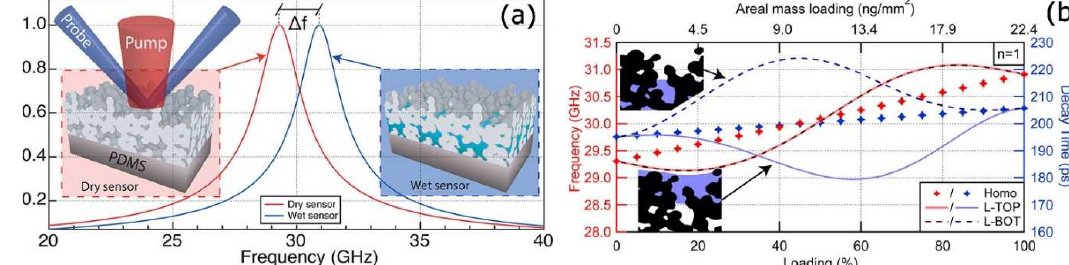
Figure 12. ( a ) Resonance behavior for the n=1 acoustic breathing mode measured by the photoacoustic signal expected for a dry (red) and fully infiltrated (blue) granular thin-film sensor. Upon water infiltration, the acoustic resonance undergoes a frequency shift of Δf = f w − f d . The two insets represent the dry and fully infiltrated device, respectively, together with a schematic of the pump and probe technique. ( b ) Frequency of the n = 1 acoustic breathing modes (left axis, red) and decay times (right axis, blue) vs. water filling within the layered adsorption scenarios L-TOP (full lines), L-BOT (dashed lines), and, for the sake of comparison, for the homogeneous wetting case (markers). Water filling is expressed both as relative volumetric loading (bottom axis) and equivalent areal mass loading (top axis). Illustration: schematics of the infiltrated device for the L-TOP (bottom picture) and L-BOT (top picture) scenarios. Water is depicted in blue, and silver is depicted in black. Adapted from ref. [38]; further permission related to the material excerpted should be directed to the